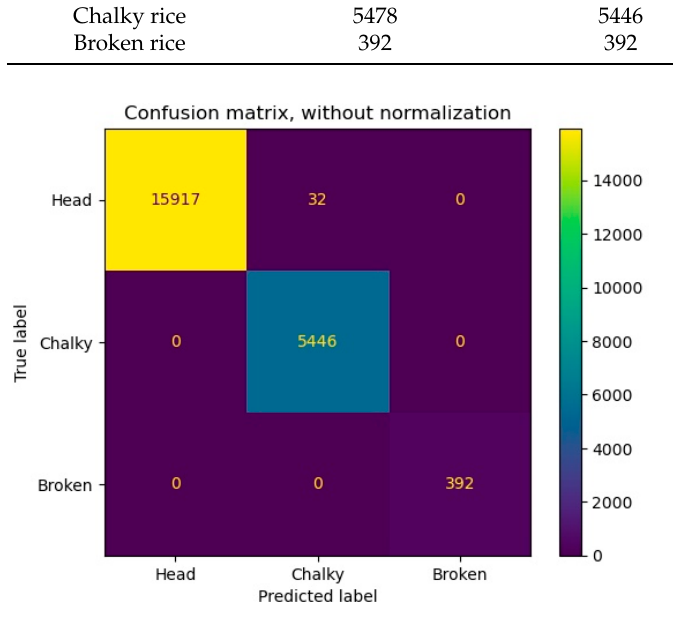
Figure 14. Confusion matrix of rice grain types after